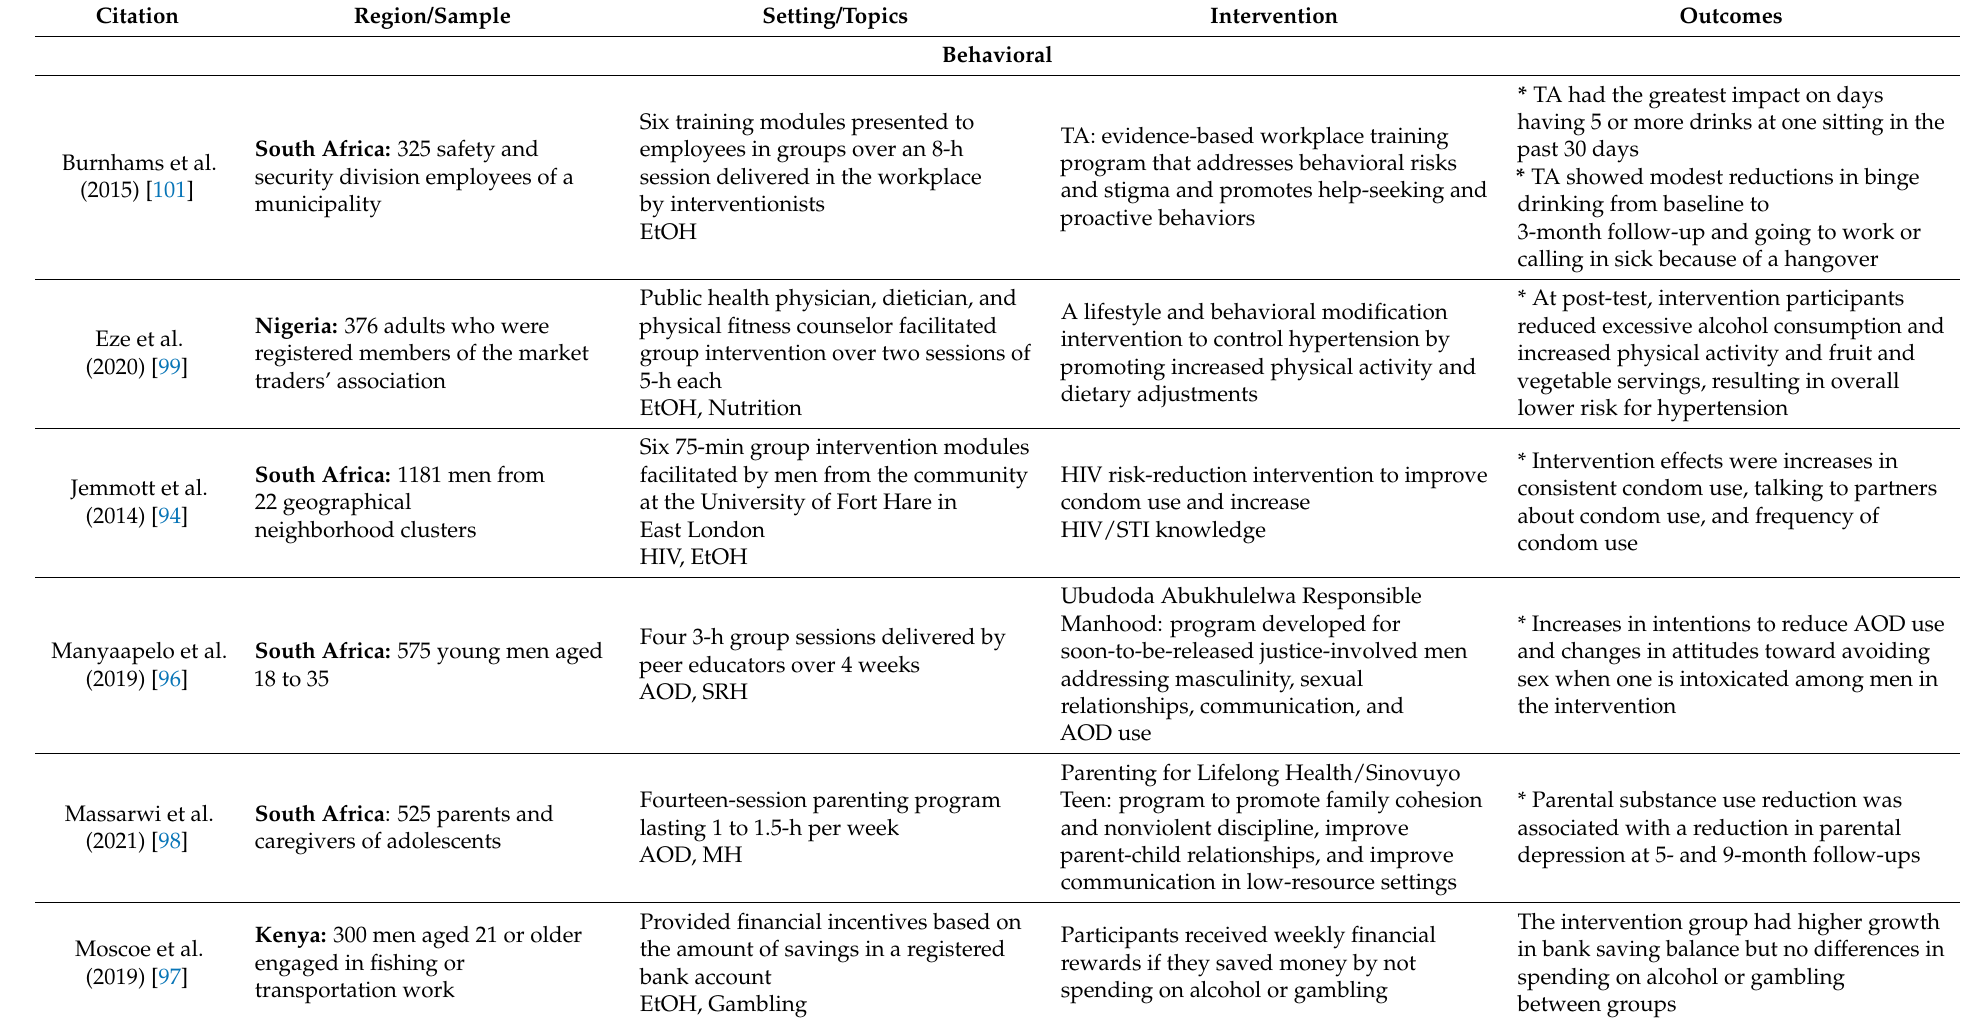
Table 3. Interventions and single-session or screening brief intervention and referral to treatment (SBIRTs) with alcohol and other drug use as secondary